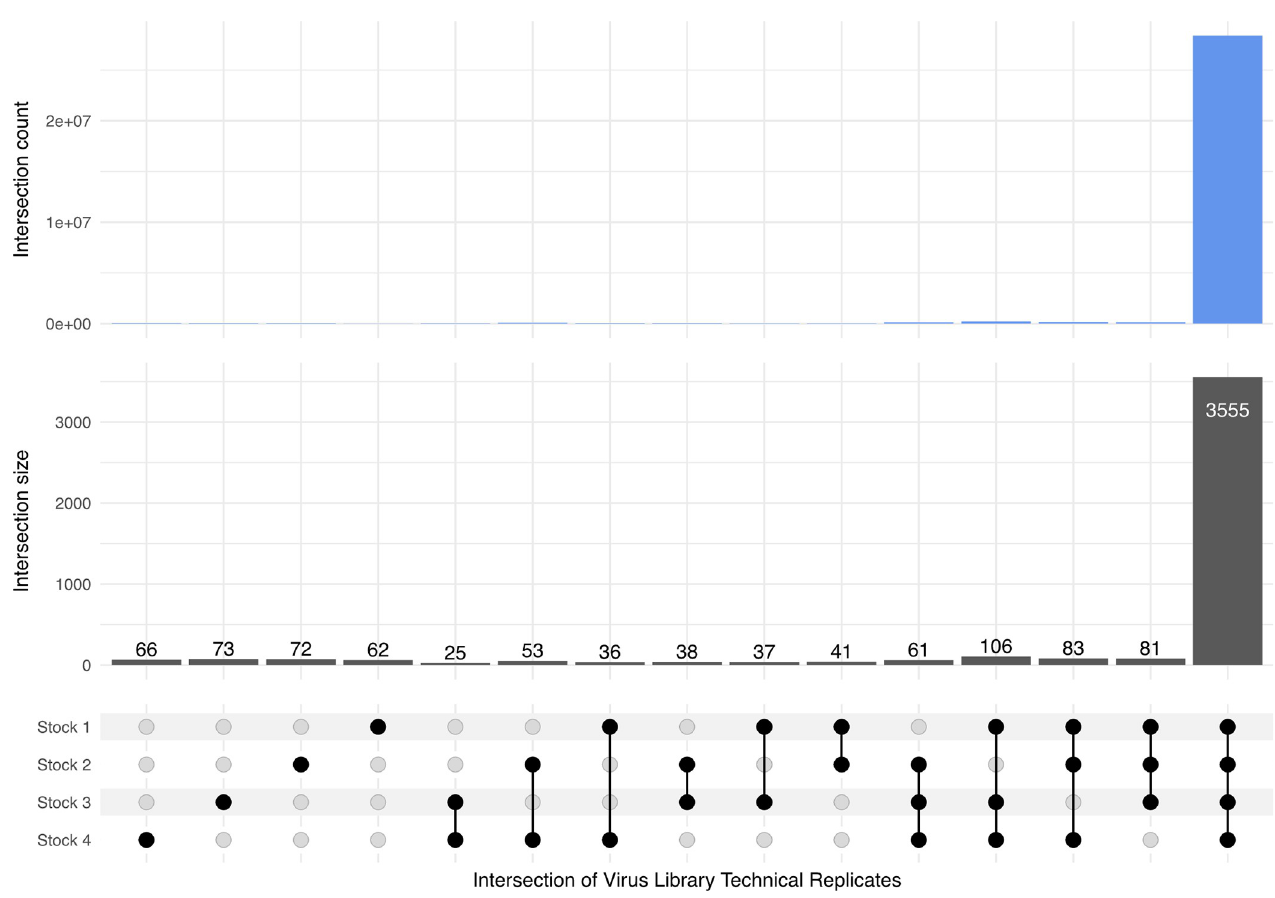
Fig 9. Technical replicates of the sequencing of the virus library. Using Illumina sequencing, one replicate of the virus library was sequenced in one run and three additional technical replicates were sequenced in a separate run. Thus, the four technical replicates were sequenced in two independent runs. The UpSet plot shows the number of barcodes that intersect amongst the four virus library technical replicates (lower panel), as well as the total counts of those barcodes in blue (upper panel). The libraries were clustered using L3 distance and a 99% reads cutoff was applied. The four replicates show a large degree of overlap in clustered